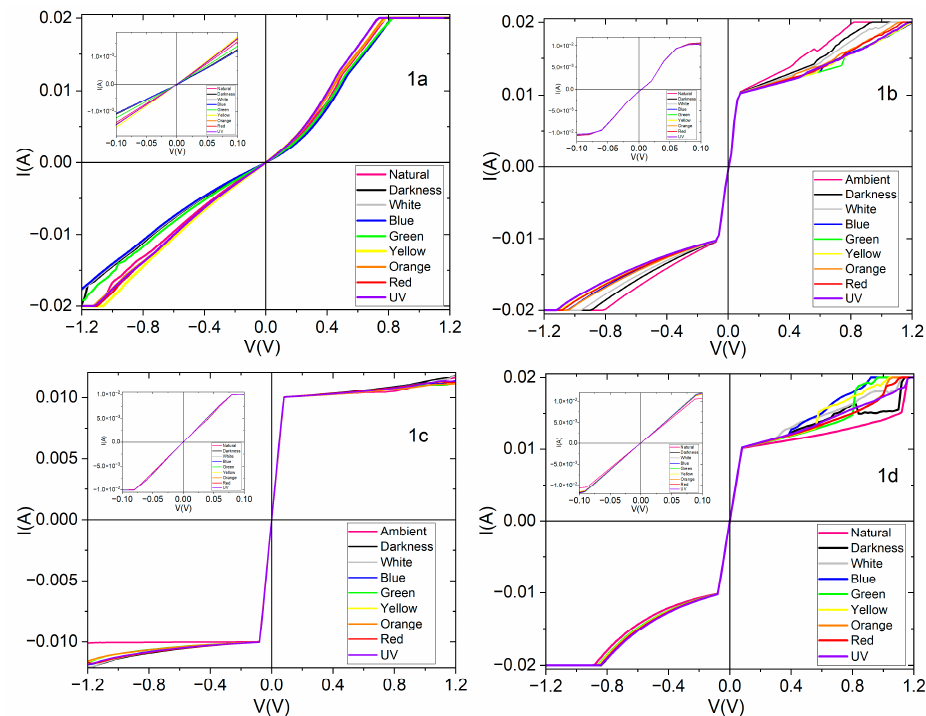
Figure 8. I–V curves from ITO/PEDOT:PSS-graphene-organotin(IV) complex/Ag devices under different lighting conditions.